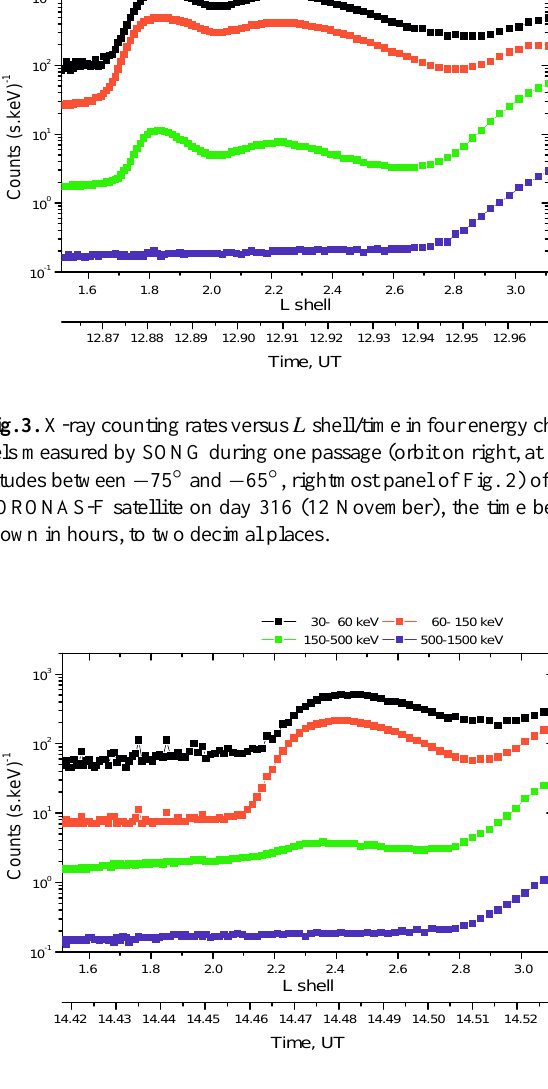
Fig. 4. Same as Fig. 3 for another passage (orbit on left, at longitudes between − 100 ◦ and − 85 ◦ , right-hand panelofFig.2)onday316(November12).